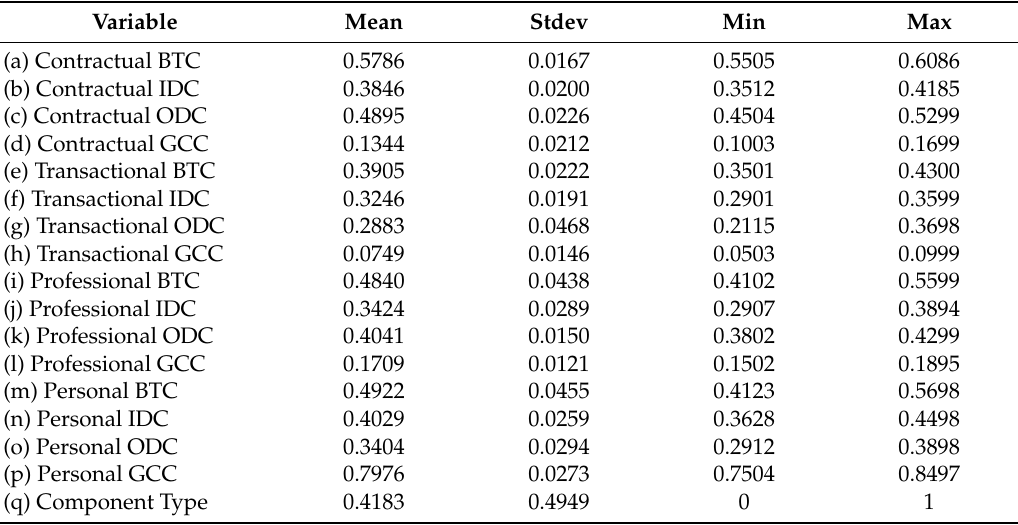
Table 6. Descriptive statistics for